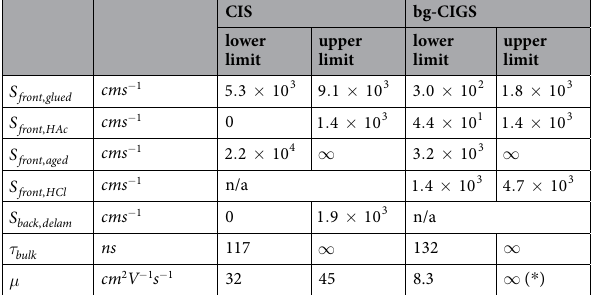
Table 3. Boundary values for the surface recombination velocities and the absorber properties based on the mathematical analysis presented in sections 4.1 (CIS) and 4.2 (bg-CIGS). For the calculations of the CIS absorber a surface recombination velocity at the Mo interface was chosen to be S back , Mo = 10 6 cms − 1 . ( * ) Simulations of transients could provide an upper limit to the mobility μ in the bg-CIGS absorber.